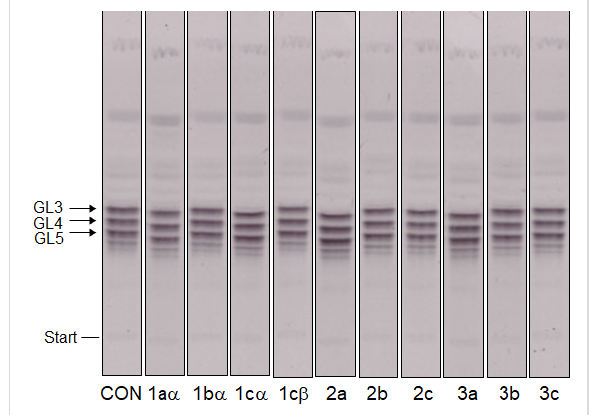
Figure 3: TLC analysis of the effects of the target compounds at 500 μ M on the production of lower lipid-linked galactan precursors. CON, control; GL3–5, glycolipids 3–5. GL3 and GL4 are products of GlfT1, GL5 is produced by